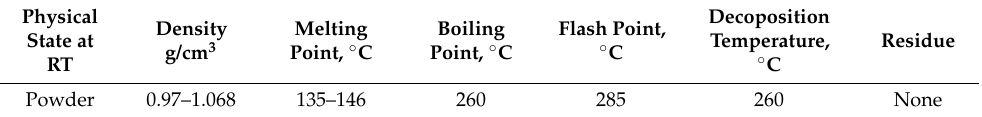
Table 3. Characteristics of Acrawax C [1,14].